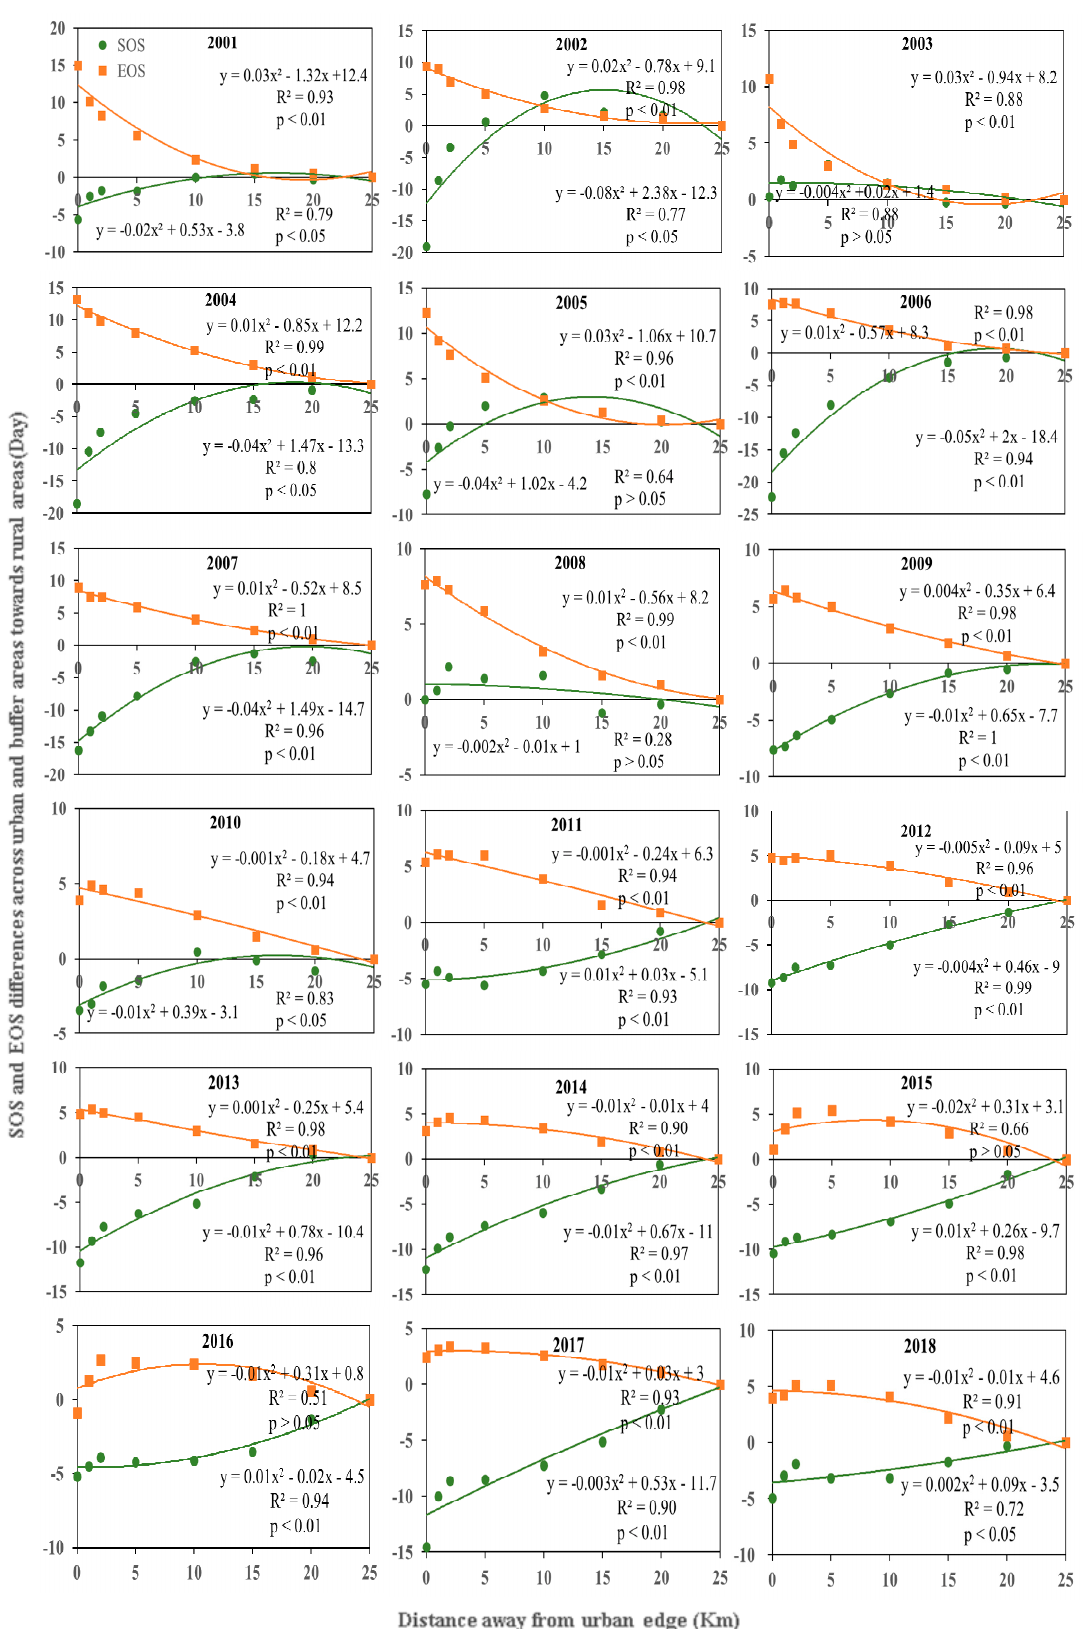
Figure 8. Phenology di ff erences across the urban–rural gradient. The green and orange dots represent the SOS and EOS di ff erences, respectively, calculated as urban minus